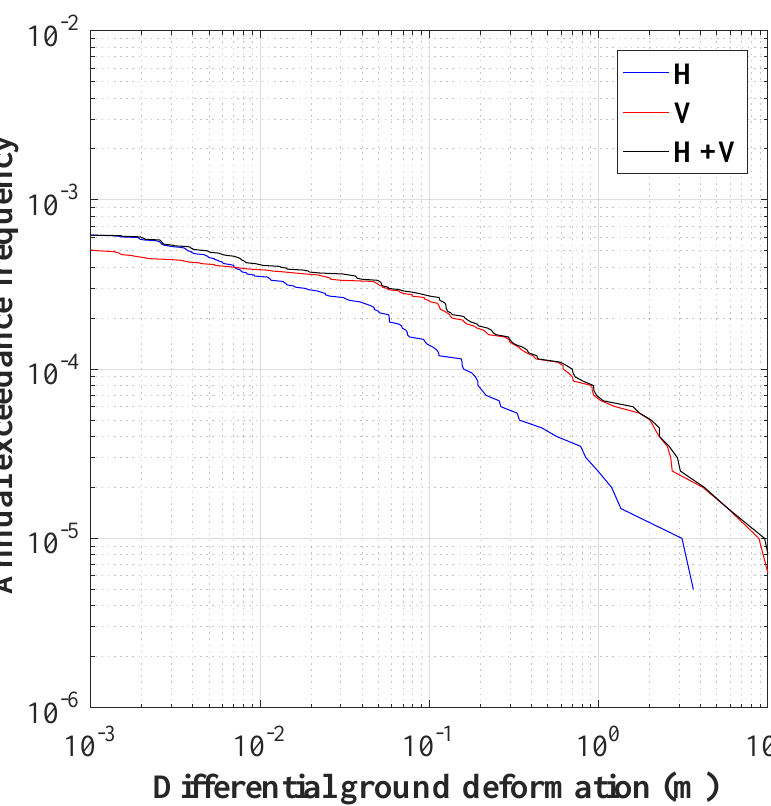
Figure 7. Differential fault displacement hazard curves between site 1 and site 2 in the horizontal, vertical and combined horizontal and vertical